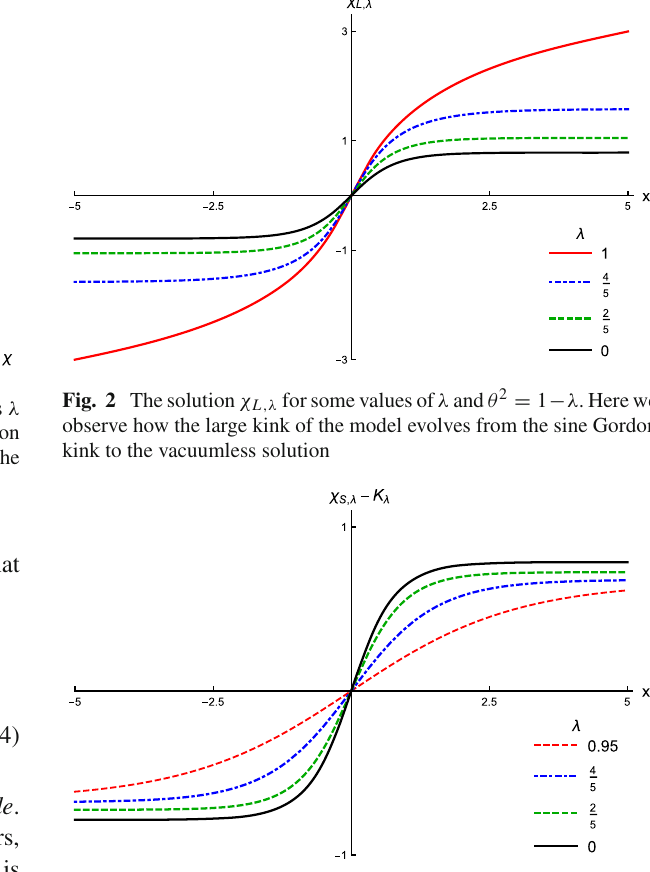
Fig. 3 The solution χ S ,λ − K λ for some values of λ and θ 2 = 1 − λ